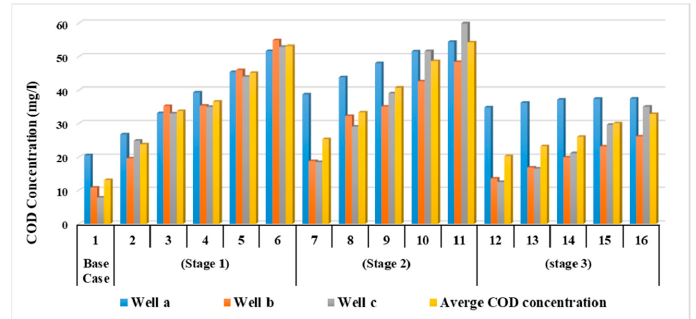
Figure 13. Comparison between COD concentration at observation wells for different scenarios of the three stages (2–16) with the base case (1). the three stages (2–16) with the base case